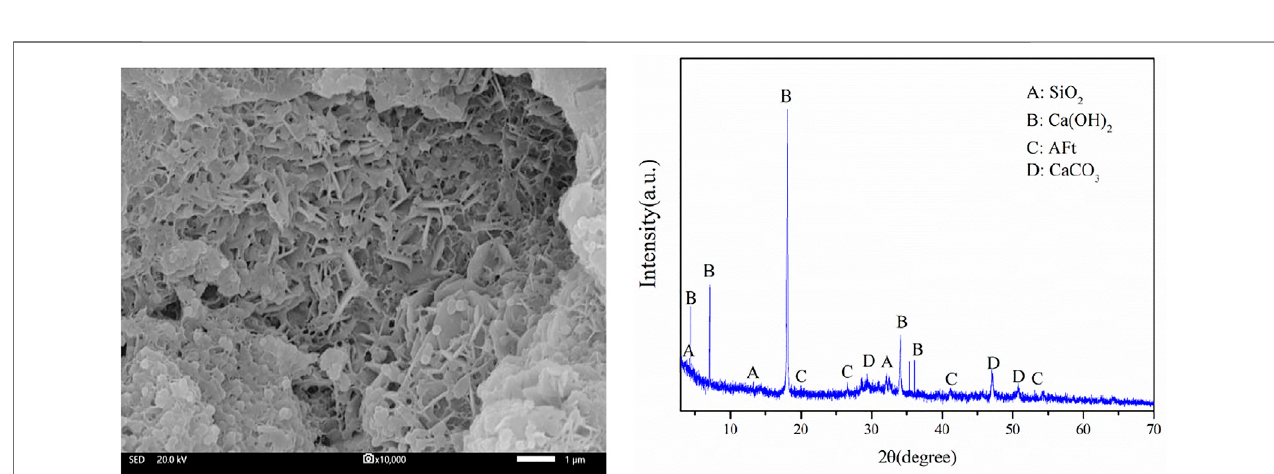
FIGURE 7 | SEM images and XRD